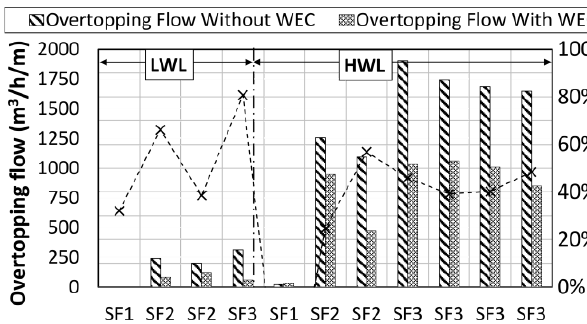
Fig. 18. Overtopping flow rate over the structure with and without the h-WEC integrated into the breakwater.